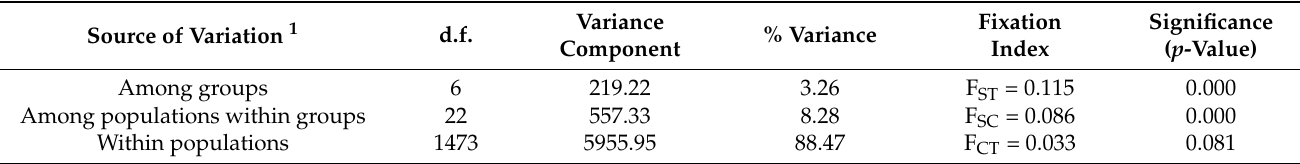
1 Variance components were calculated using only five polymorphic loci in the Set 2 microsatellite markers; d.f.: degree of freedom; F proportion of genetic variation within populations, F SC : variation among populations within groups, F CT : variation among groups (seven groups were set based on their